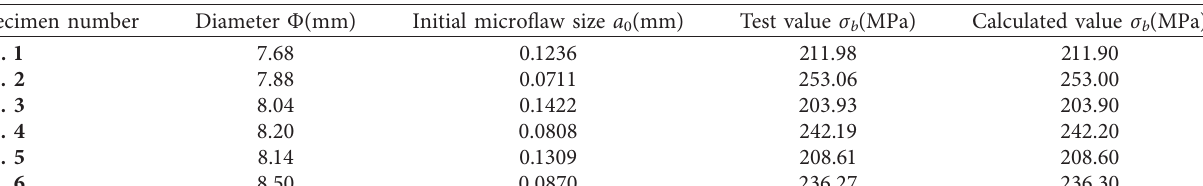
Table 3: Calculated values of extreme strength of gray cast iron HT200 specimens.